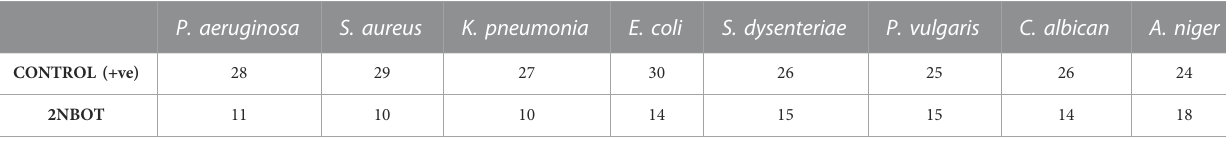
TABLE 5 Antimicrobial activity of